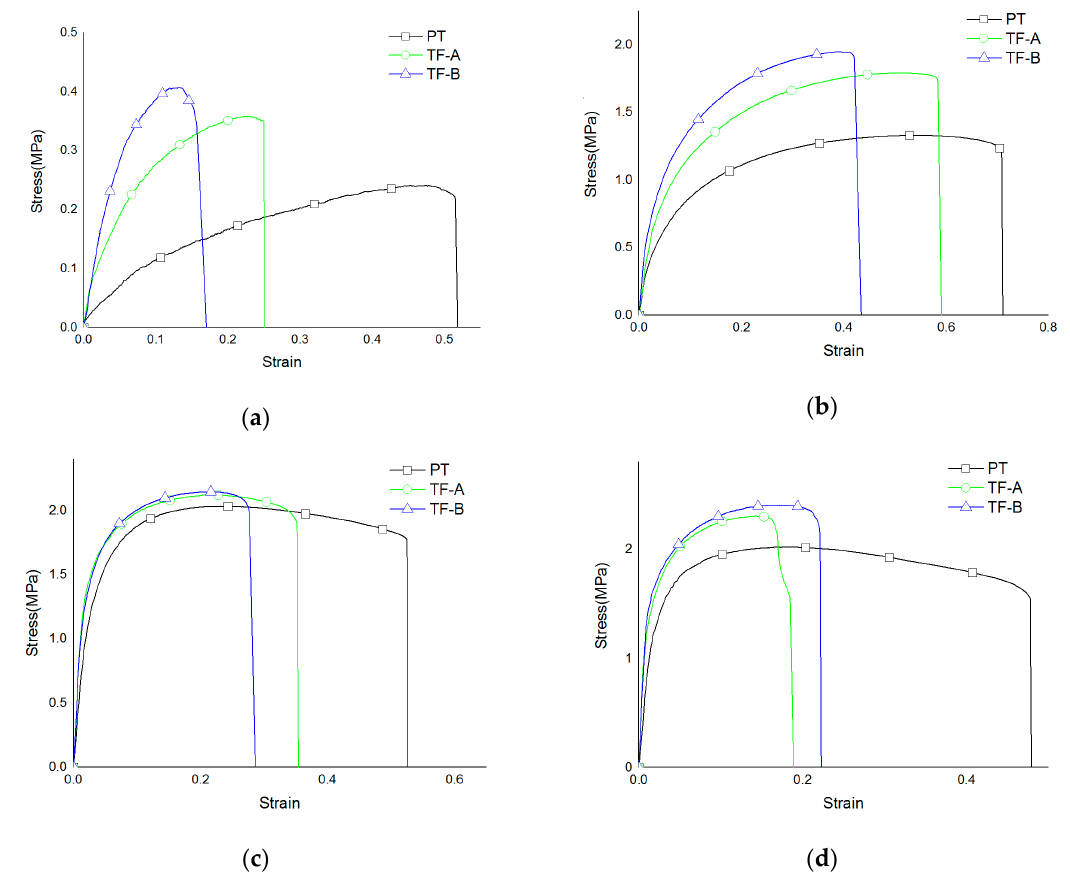
Figure 9. Stress versus strain relationship associated with di ff erent curing times of typical specimens.